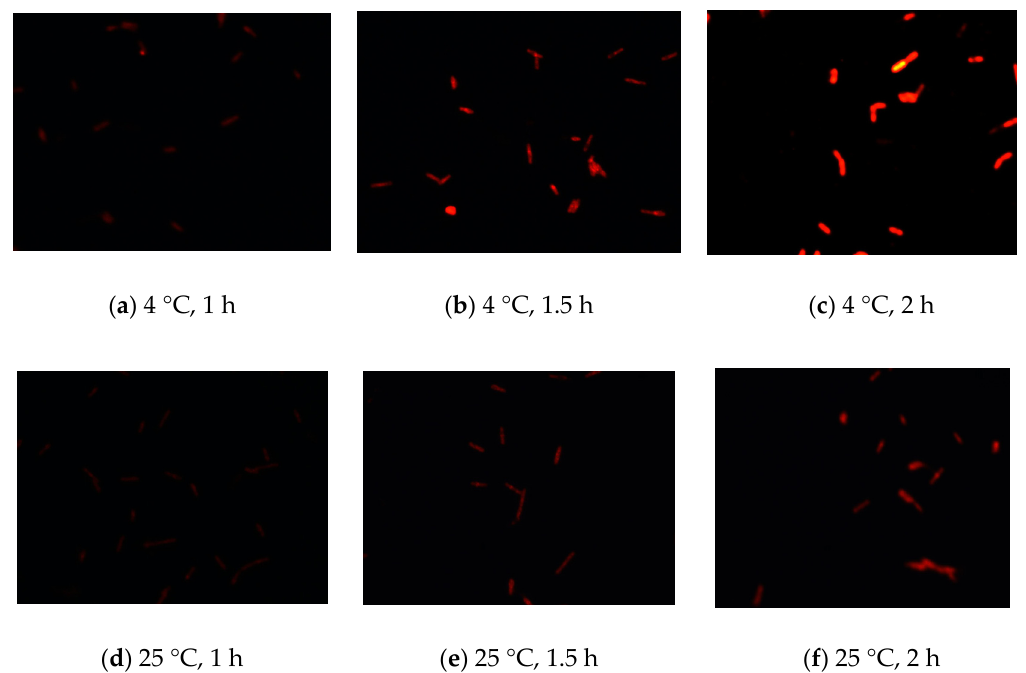
Figure 1. Establishment of the optimal fixation conditions for detecting E. coli using fluorescence in situ hybridization (FISH). ( a – c ) E. coli cells were fixed using 3% paraformaldehyde at 4 ◦ C for different times (1, 1.5, or 2 h) and then stained with Cy3. ( d – f ) E. coli cells were fixed using 3% paraformaldehyde at 25 ◦ C for different times (1, 1.5, or 2 h).